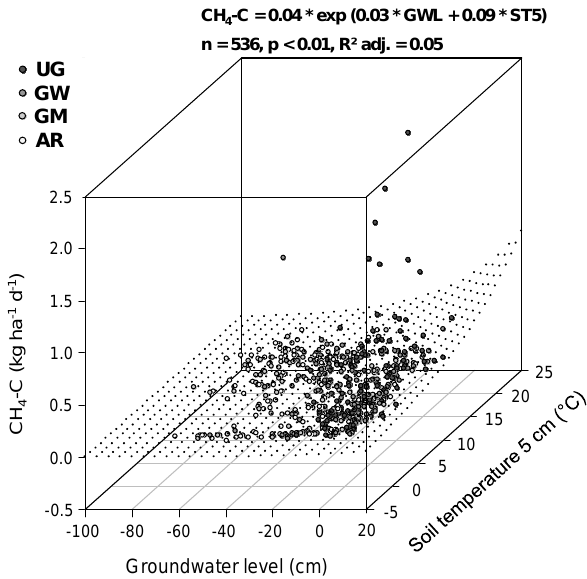
Figure 8. Relationship of daily CH 4 fluxes to groundwater level and mean daily soil temperature at 5cm depth. GWL in the equation is groundwater level (cm) and ST5 is soil temperature at 5cm depth ( ◦ C). R 2 adjusted was estimated for predicted vs. obtained values.